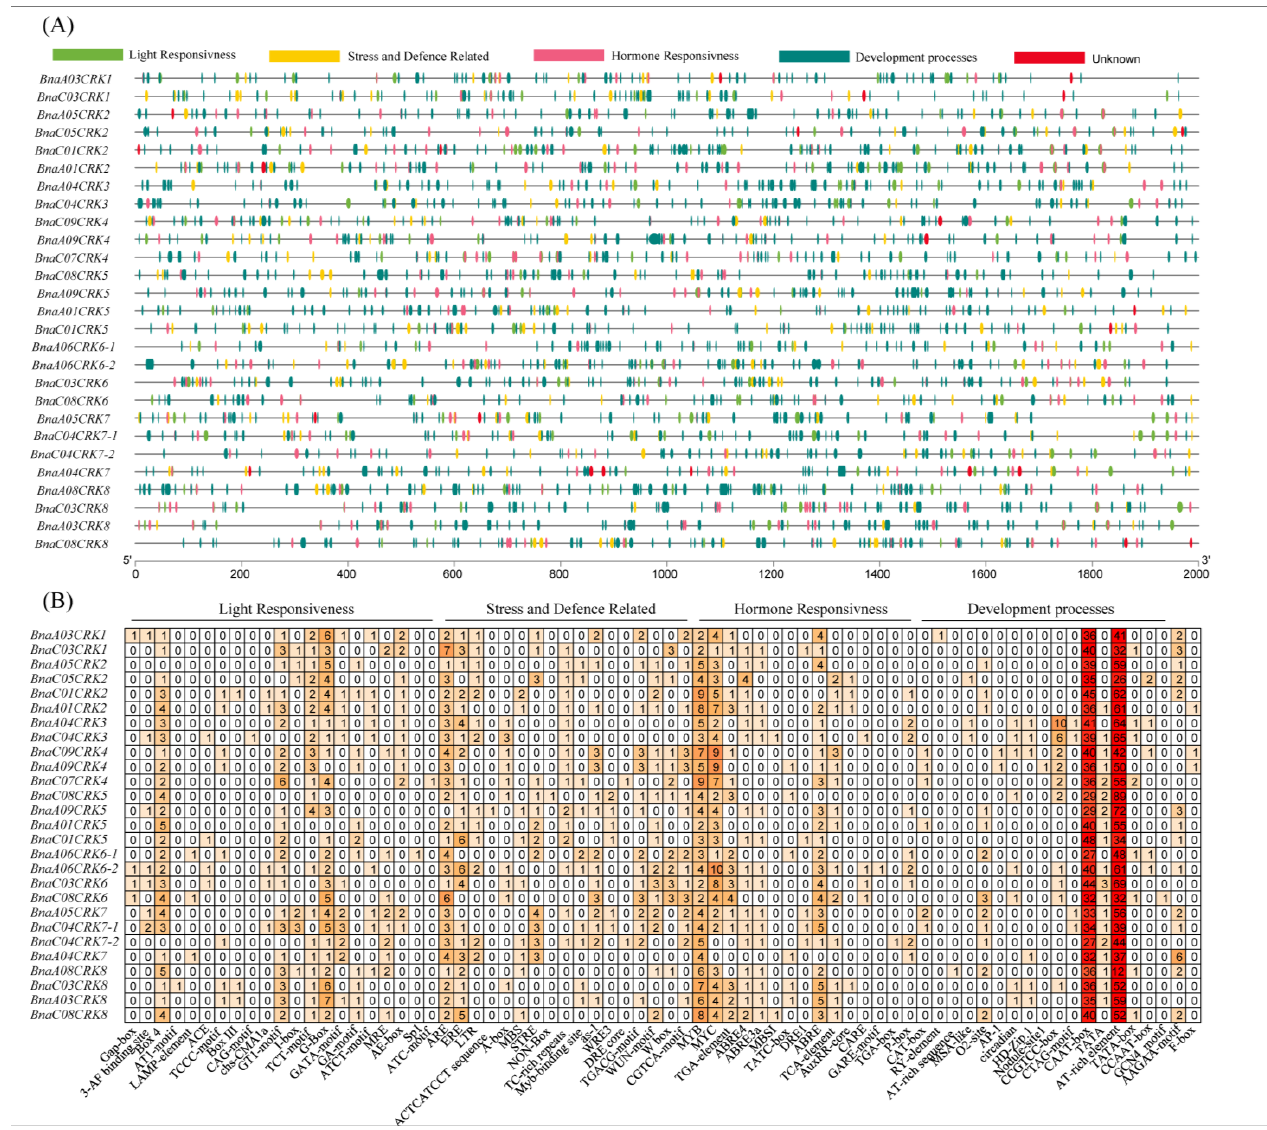
Figure 8. cis- acting regulatory elements analysis of the BnaCRKs. ( A ) Distribution of light-responsive, stress and defense-related, hormone-responsive, and development-related cis-core elements in the promoter region of each member of the BnaCRK gene family. ( B ) Total number of each cis -acting element in the promoter region of the BnaCRKs.